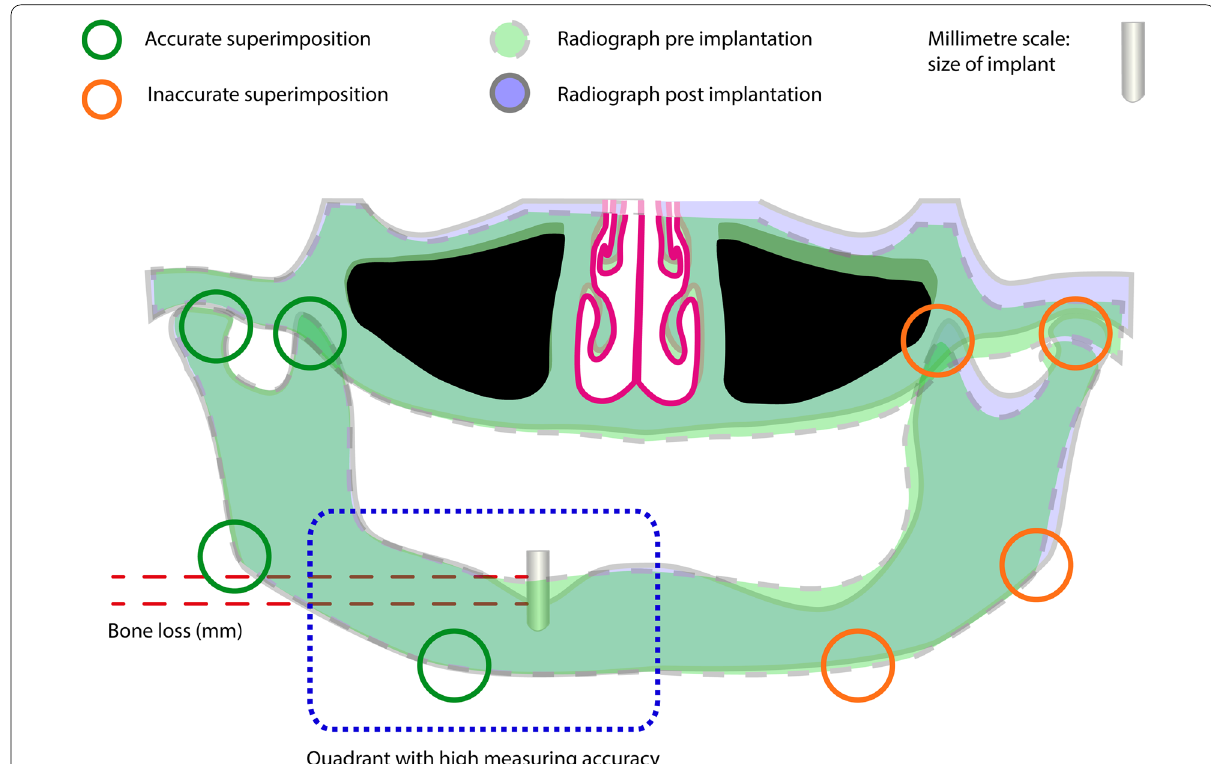
Fig. 4 Superimposition and bone resorption measurement: specific marks in the radiographs (green circles) were used to achieve an accurate congruence of the pre and post implantation radiographs in the examined quadrant (blue box). The known size of an implant was used to set the millimetre scale and the time-dependent bone loss was measured (red-dashed lines)